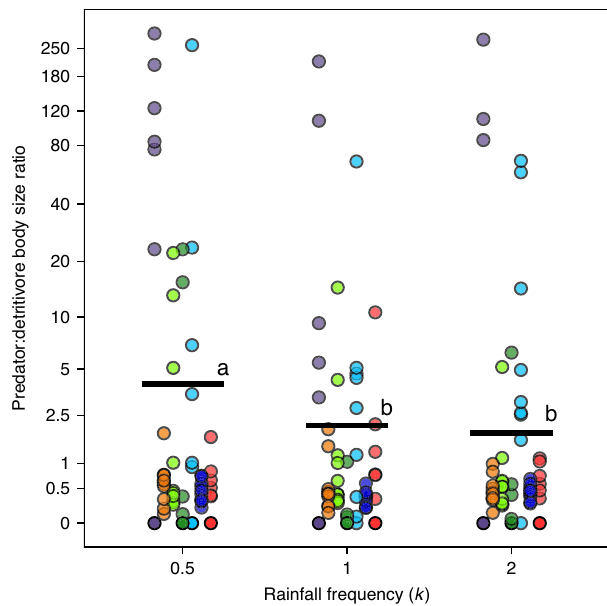
Fig. 3 Predator:detritivore body size ratio varies across the sites and change under rainfall frequency. In fl uence of rainfall frequency ( k ) and site on predator:detritivore body size ratio within each microcosm. Horizontal bars denote mean values; different letters indicate statistically signi fi cant differences (GLM/Tukey contrasts, α = 0.05). The best model detected site ( χ 2 = 208.6, P < 0.001) and k ( χ 2 = 7.1, P = 0.028, Δ AICc = 6) in fl uencing predator abundance, with no signi fi cant interaction between these variables. k equals to 1 represents typical average values of rainfall frequency; values lower and higher than 1 represent deviance from typical values, and characterize extreme events. Circle colors indicate sites of the experiment; colors match with the sites plotted in Fig. 1a. Jitter function was used to add random noise to data in order to prevent